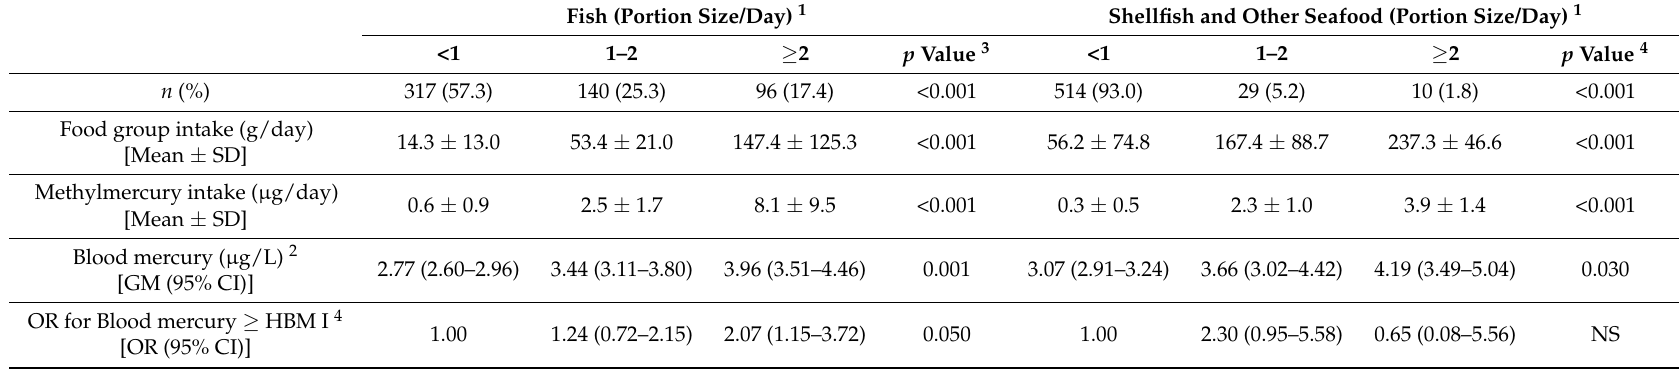
Table 6. The dose-response relationship between seafood intake and blood mercury